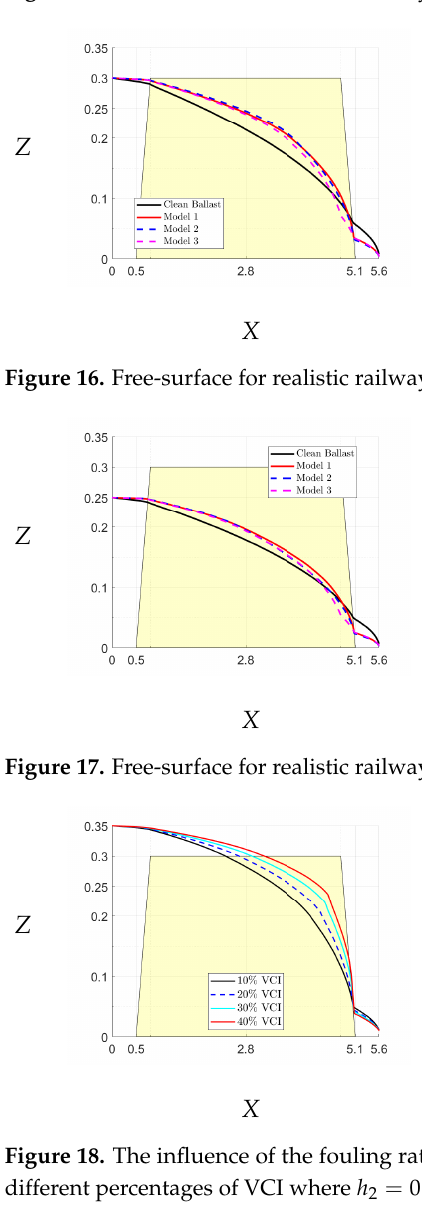
Figure 15. Free-surface for realistic railway ballast at height h 1 = 0.35.